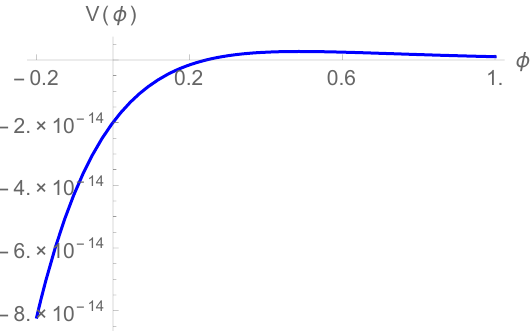
Figure 1. Figure showing the nature of the scalar field potential in the Einstein frame where f ( R ) = ( 1/ α ) exp ( α R ) . In the above figure the field and its potential both are expressed in Planck units (where the Planck mass is set as unity) in which α = 10 12 .